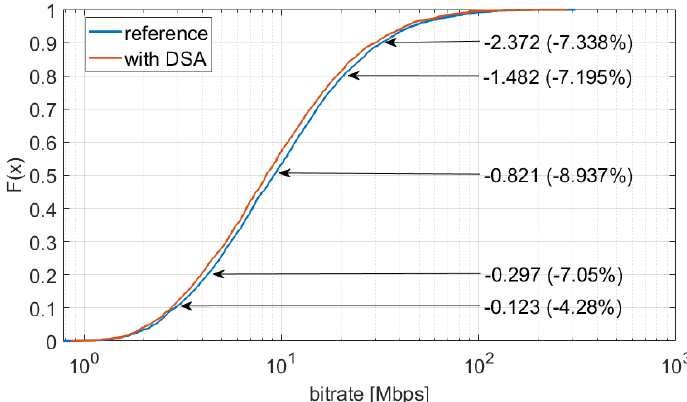
Figure 6. Single simulation repetition results—user